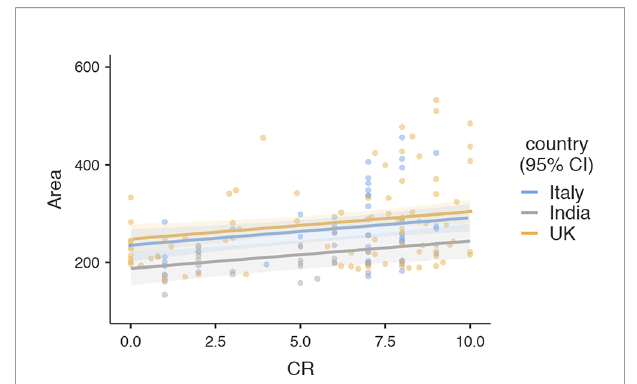
FIGURE 3 | Scattergram illustrating the relationship between autism spectrum quotient and articulation space. Regression lines and con fi dence intervals correspond to results of the hierarchical linear model presented in Table 2 (Area, Articulation Space; AQ, Autism Spectrum